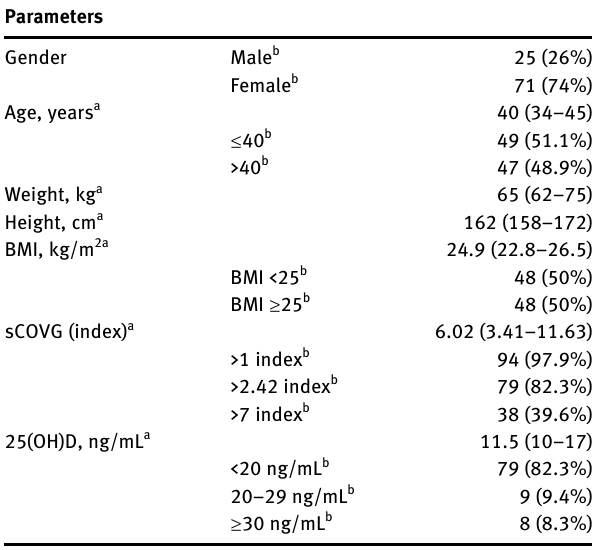
Table  : Population characteristics (n= 